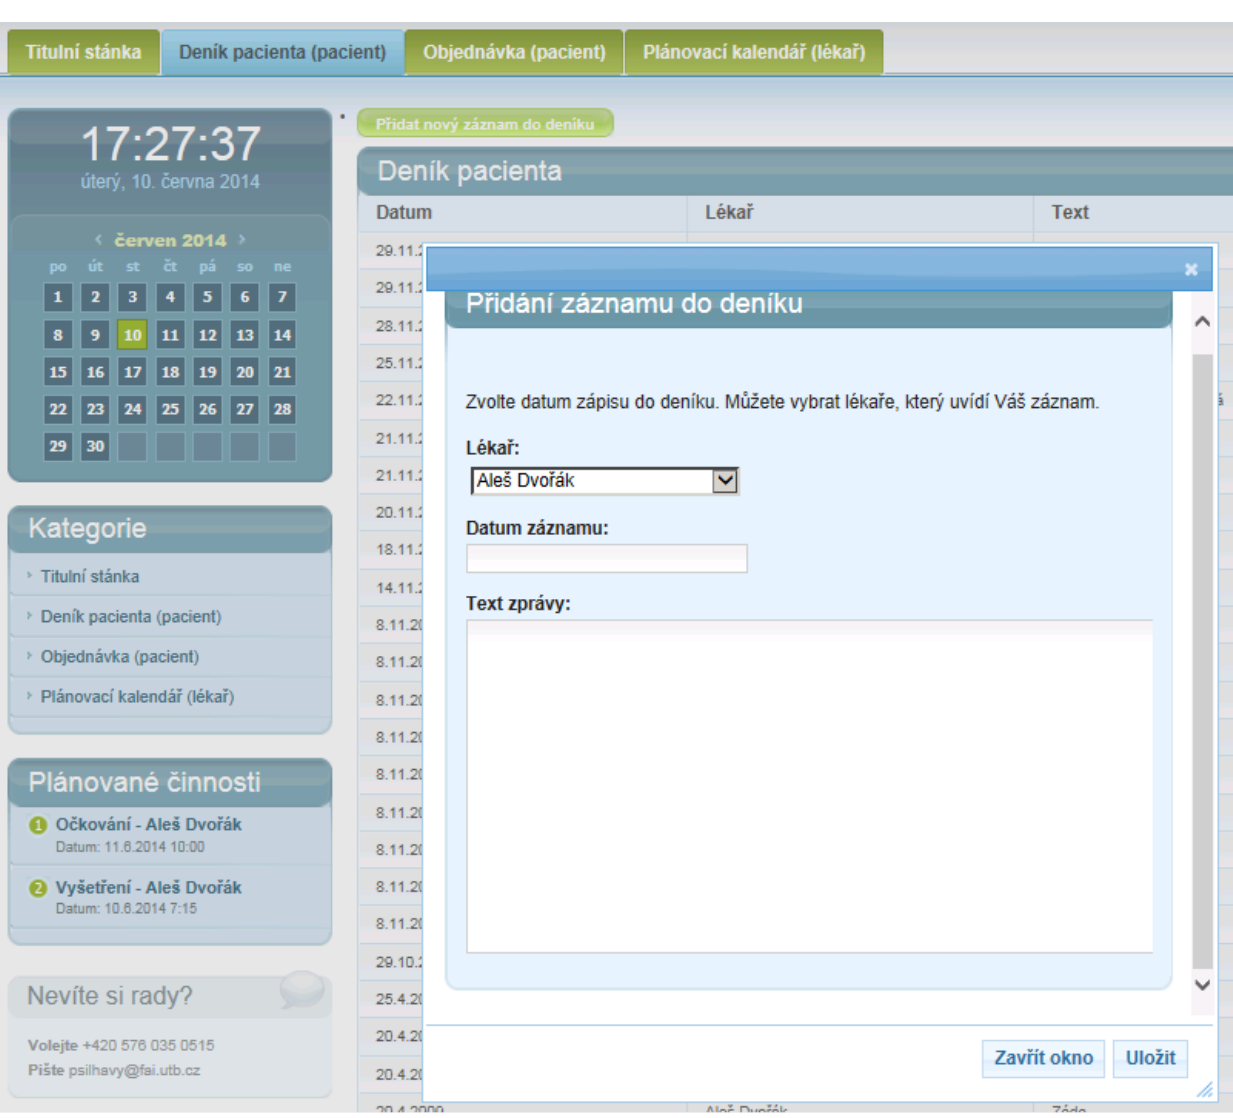
Figure 7. Patient’s diary entry